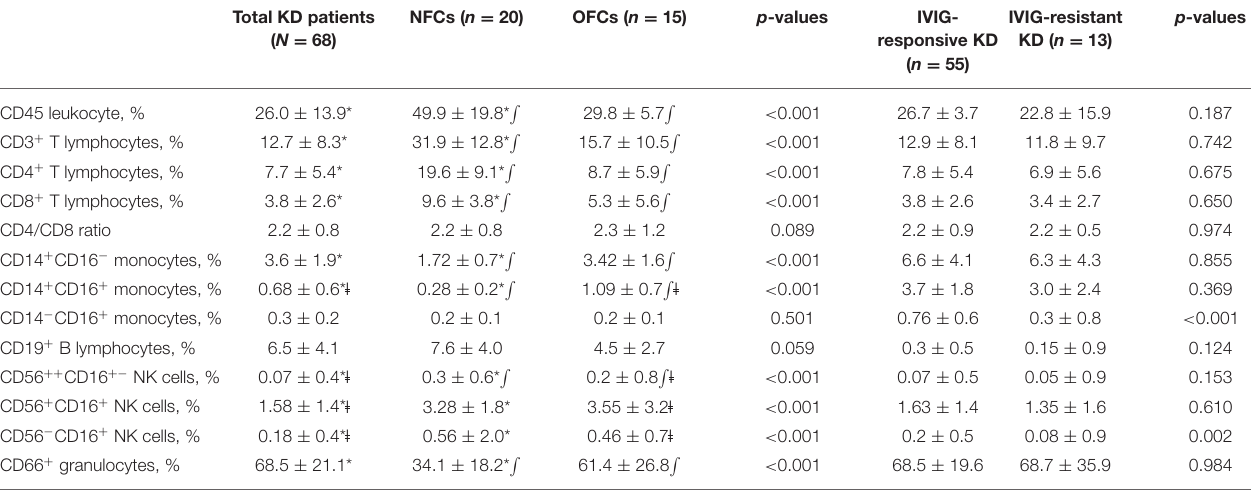
TABLE 2 | Immune cell profiles in Kawasaki disease patients (IVIG-responsive vs. IVIG-resistant) and comparison with controls at the time of diagnosis. Total KD patients NFCs ( n = 20) OFCs ( n = 15) p ( N = 68)